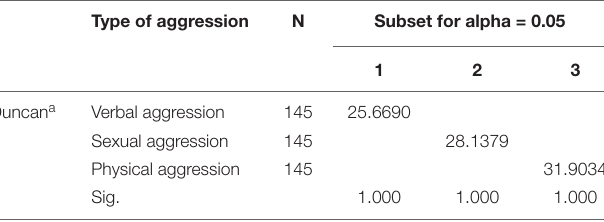
TABLE 2 | Post-Hoc test showing the difference among physical aggression, verbal aggression, and sexual aggression.